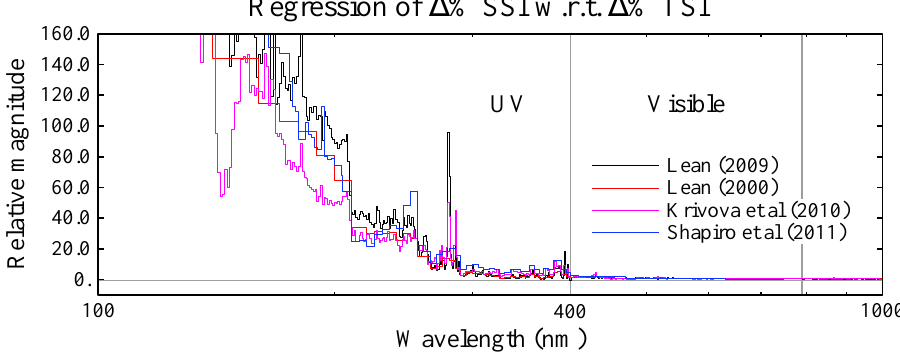
Fig. 3. Ratio of spectral irradiance variability to total solar irradiance variability from UV to Near IR. This shows the regression of the % change in solar spectral irradiance (SSI) at each wavelength to the % change in TSI for 4 separate estimates (Lean, 2000, 2009; Krivova et al., 2010; Shapiro et al., 2011) (cf. Fig 7 in Schmidt et al. (2011)).